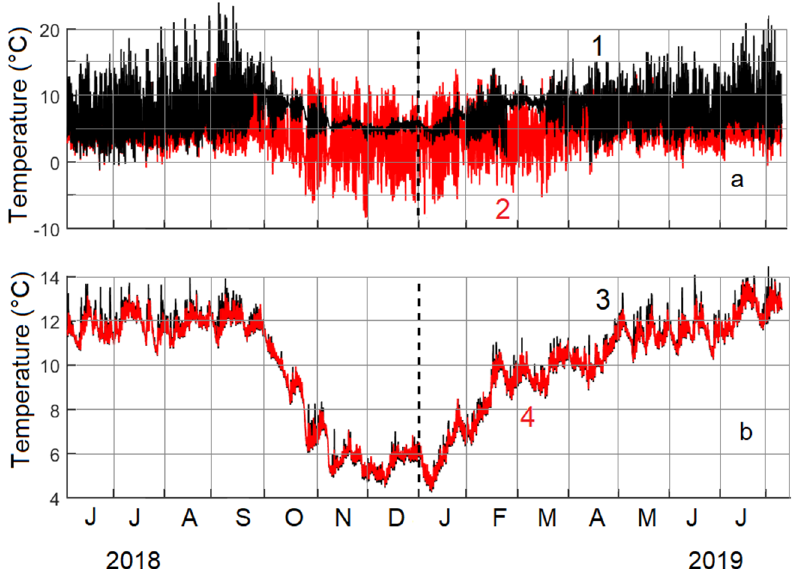
Figure 7. Hourly variability of air and water temperature in the area of the floating weather station. ( a ) At a height of 0.1 m above the level of the lake (1) and at a height of 2 m (2). ( b ) Temperature fluctuations directly below the water surface (3) and at a depth of 2 m (4).